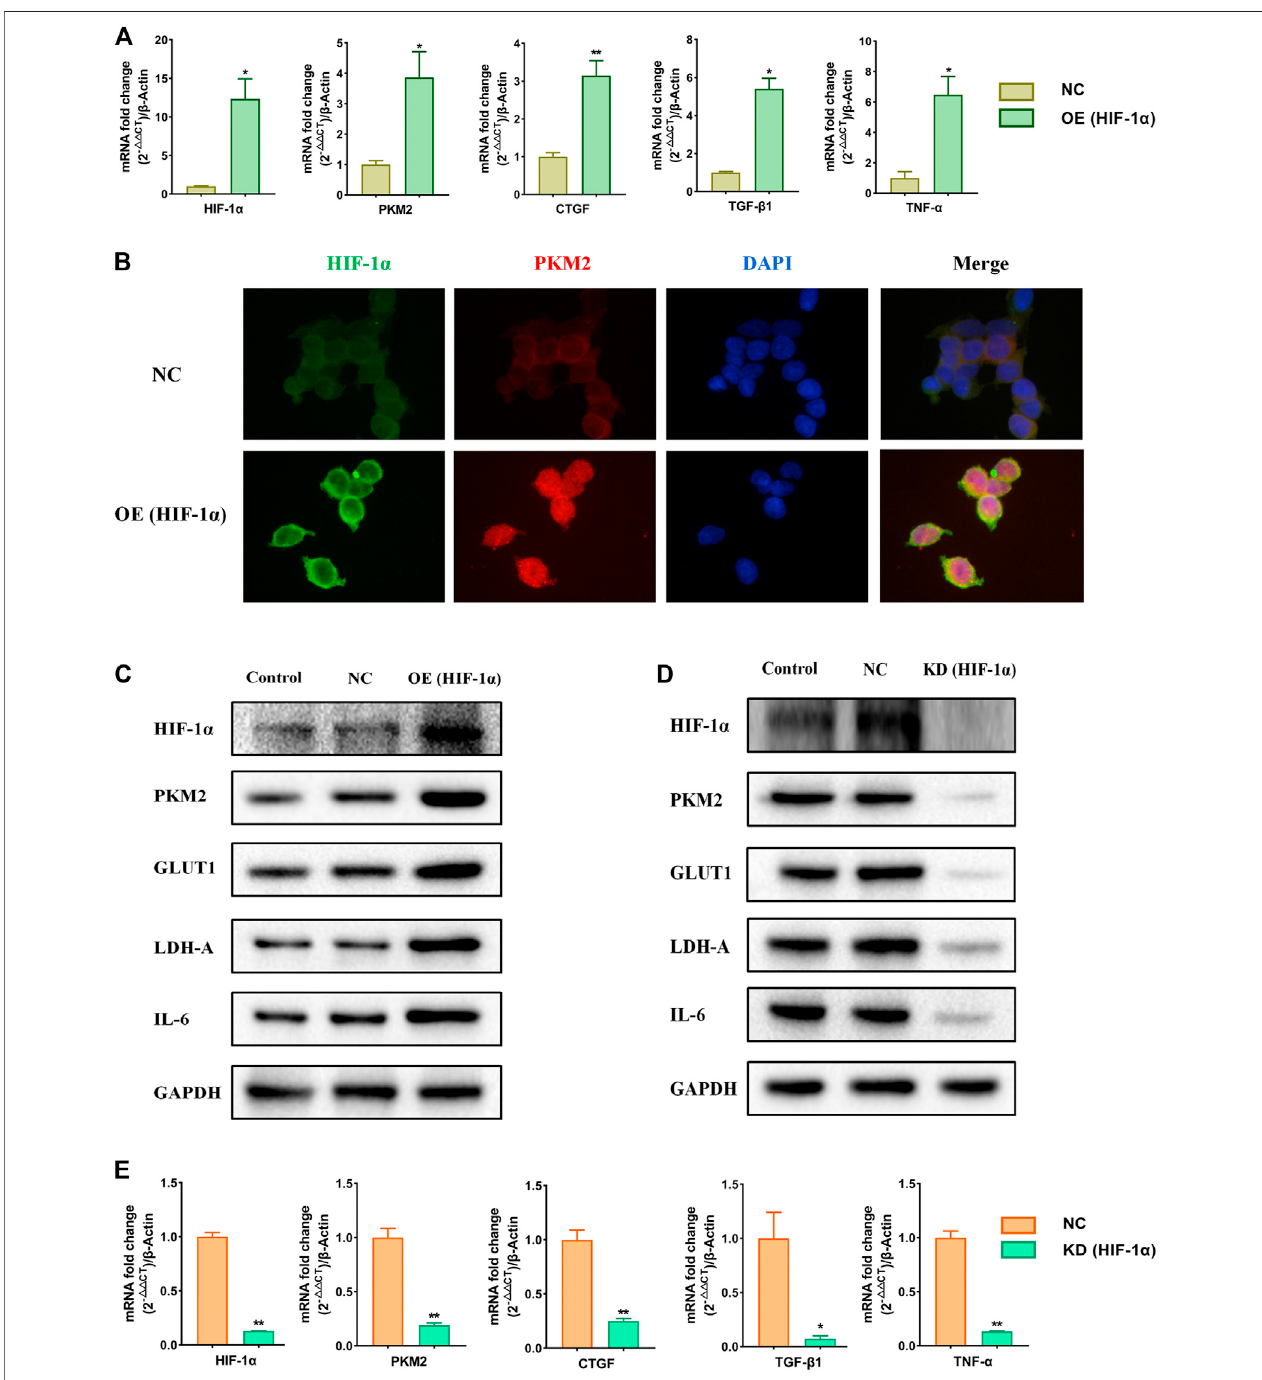
FIGURE 5 | Effects of over-expression and knockdown of HIF-1 α on relative markers in HEK293T cells. Cells were divided into following groups: conrtol, negative control (NC), HIF-1 α -overexpression group (OE) and HIF-1 α -knockdown group (KD). (A) Effects of over-expression of HIF-1 α on mRNA levels of HIF-1 α , PKM2, CTGF, TGF- β 1, and TNF- α were examined by using qPCR. (B) Effects of over-expression of HIF-1 α on immuno fl uorescence staining of HIF-1 α and PKM2. (C) Effects of over- expression of HIF-1 α on proteins of HIF-1 α , PKM2, GLUT1, LDH-A, and IL6 in HEK293T cells were examined by using western blotting. (D) Effects of knockdown of HIF-1 α on proteins of HIF-1 α , PKM2, GLUT1, LDH-A, and IL6 in HEK293T cells were examined by using western blotting. (E) Effects of knockdown of HIF-1 α on mRNA levels of HIF-1 α , PKM2, CTGF, TGF- β 1, and TNF- α in HEK293T cells were examined by using qPCR. * p < 0.05 and ** p < 0.01.